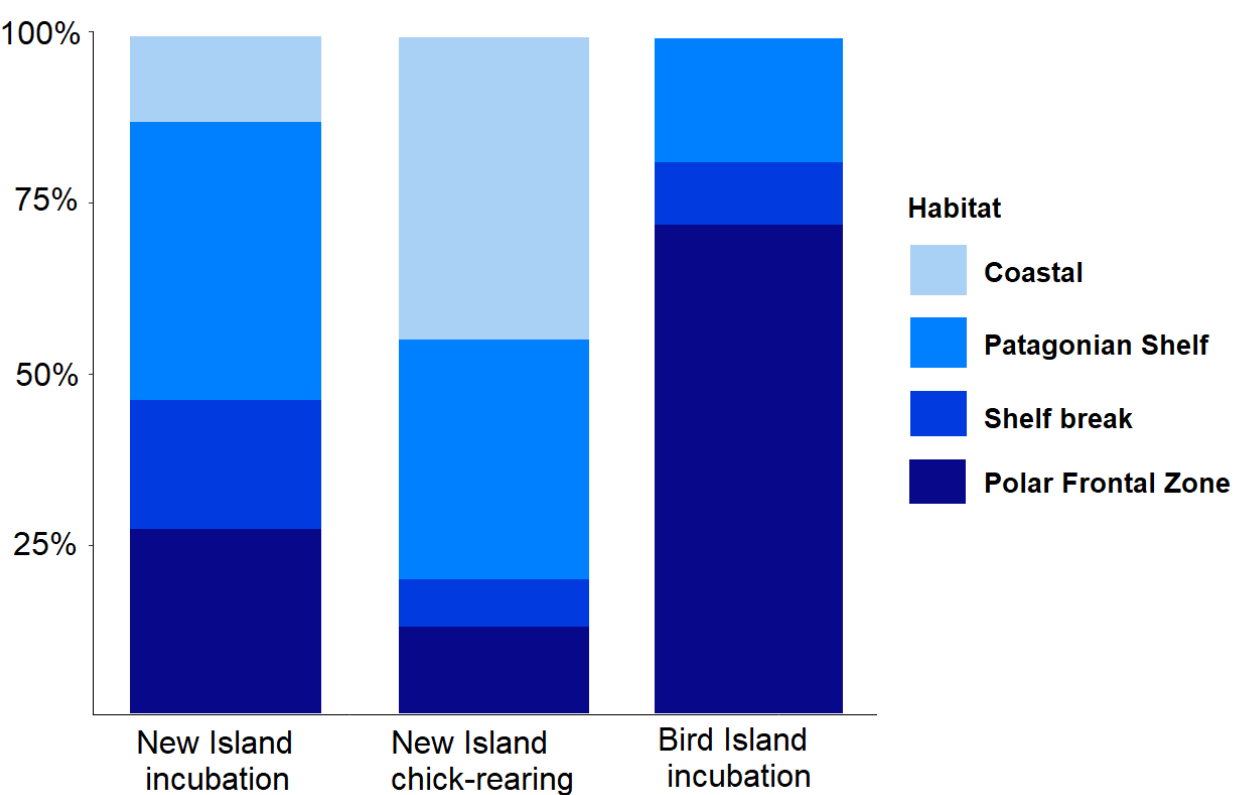
Figure 7. Habitat use of Thin-billed Prions from two colonies in the Falkland Islands, separately for the breeding stages, shown as circular histograms (polar plots) indicating the travel direction.